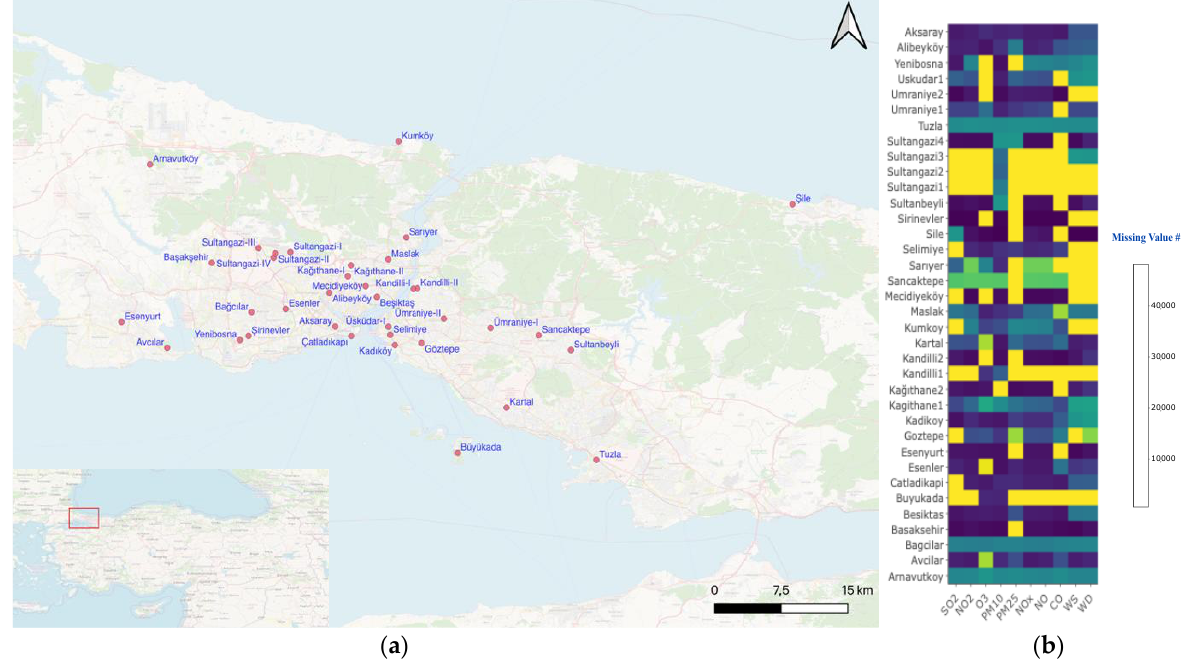
Figure 1. ( a ) Air quality monitoring stations in Istanbul; ( b ) missing data heatmap. Table 1. Preceding-term analysis of PM 10 . Blue names indicate Anatolian Side, Green names is for stations located in the European Side.